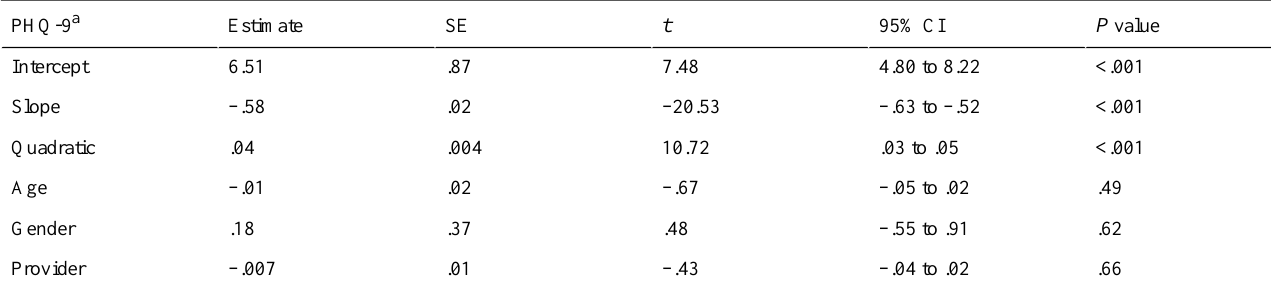
Table 3. Age, gender, and provider as predictors of the intercept, slope, and quadratic components for depression symptoms.